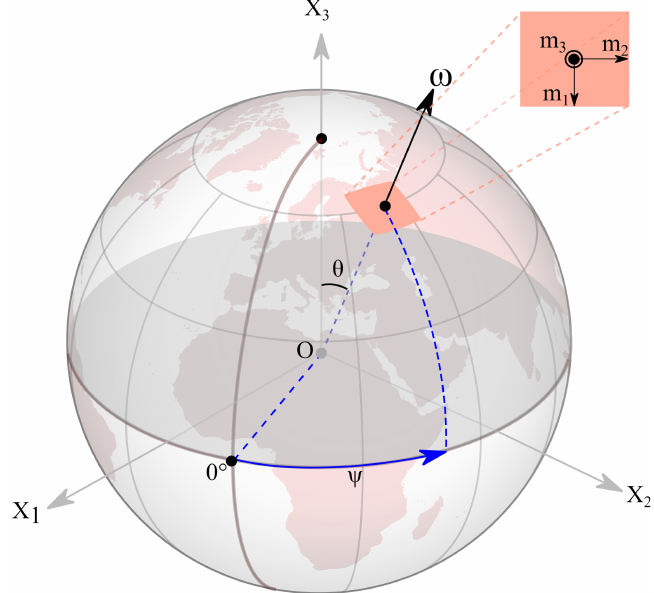
Figure 1. Terrestrial reference frame. m 1 and m 2 are the coordinates of the rotation pole. ψ and θ are the declination and inclination introduced by Laplace